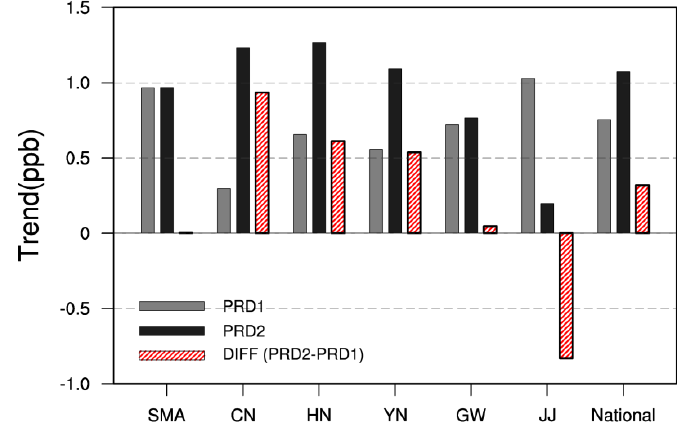
Figure 8. Normalized anomalies (PRD2–PRD1) of meteorological factors, with TMAX (red), SR (yellow), RH (sky blue), PRCP (blue), and WS (green) in the air quality regions (Seoul Metropolitan Area, SMA; Central region, CN; Honam, HN; Yeongnam, YN; Gangwon, GW; Jeju, JJ) during the O 3 season.